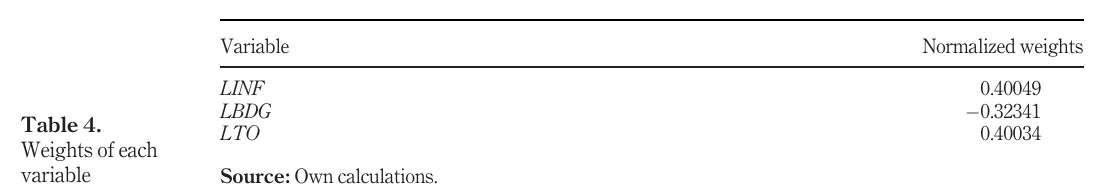
Table 3. Descriptive statistics of studied variables